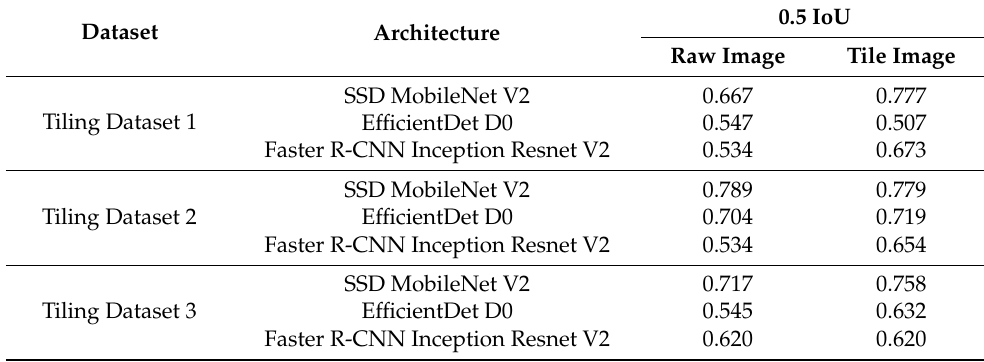
Table 9. Evaluated model on the test dataset.